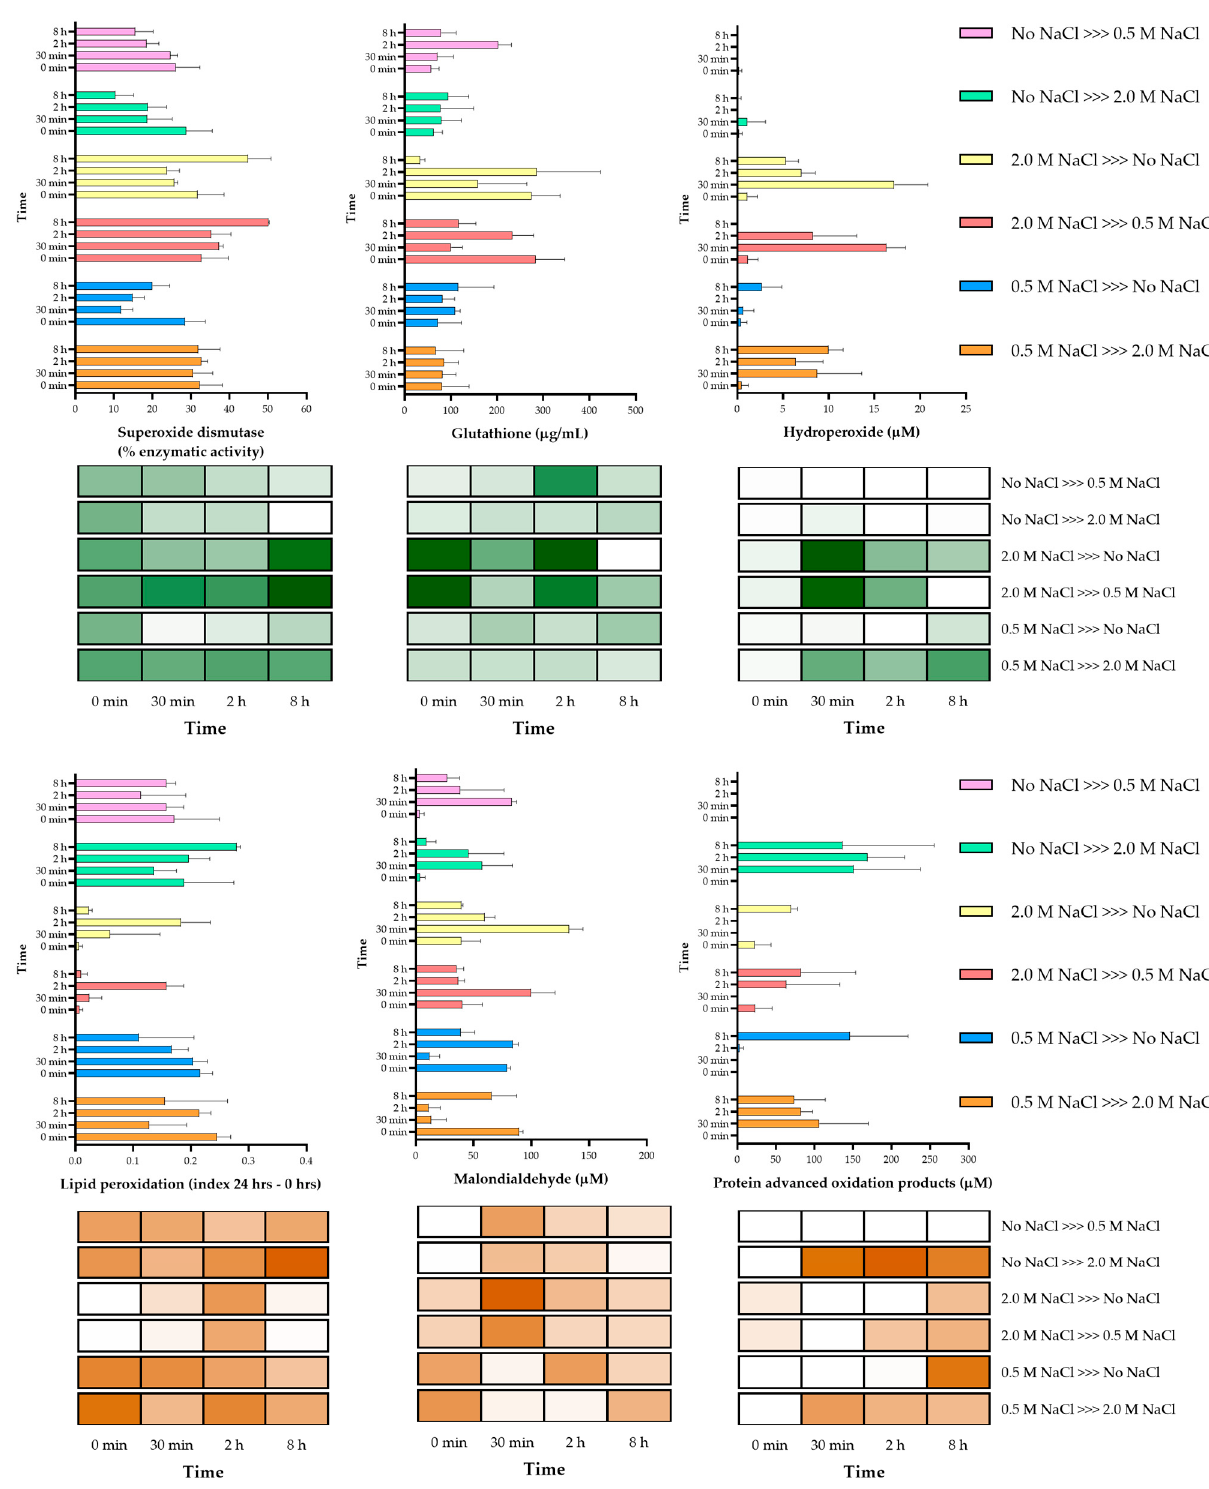
Figure 9. Oxidative stress and antioxidant markers evaluated in A. sydowii after osmotic shock. Superoxide dismutase (SOD) and glutathione (GSH) (antioxidants markers, green in the heat maps), malondialdehyde (MDA) and protein advance oxidation products (PAOP) (oxidative damage markers, red in the heat maps) were analyzed. Columns represents the average of at least three replicates, and bars represent the standard deviation. Details of statistical differences are shown in Supplementary Table S7.